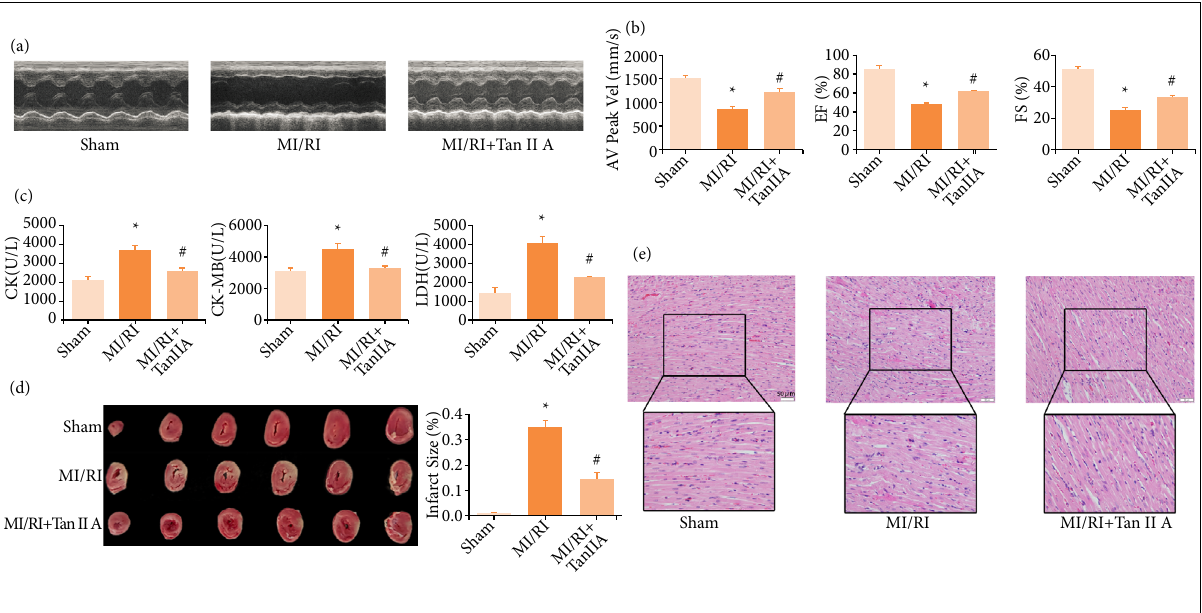
Figure 1 - Tanshinone IIA improved cardiac functions against MI/RI. (a) Representative echocardiograms for each group. (b) Quantification of AV Peak Vel, EF% and FS% (n ≥ 3 per group). (c) Levels of CK, CK-MB and LDH in rat serum (n ≥ 3 per group). (d) Representative TTC-stained heart images and quantification of infarct sizes. Percentage infarct size =(Infarct size / viable size) × 100% (n ≥ 3 per group). (e) Representative HE staining of heart transverse sections (scale bar = 50